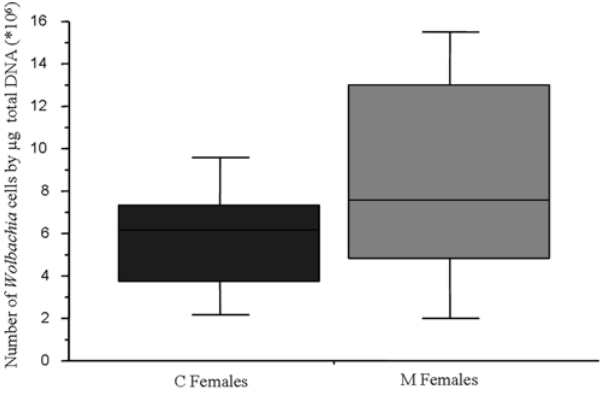
Figure 1. Titer of each Wolbachia strains in A.vulgare ovaries. Comparative analysis of the titer of Wolbachia in ovaries between C females and M females was performed using qPCR of the wsp gene. The two strains of Wolbachia exhibited a similar titer ( , 7,640 6 10 6 bacteria